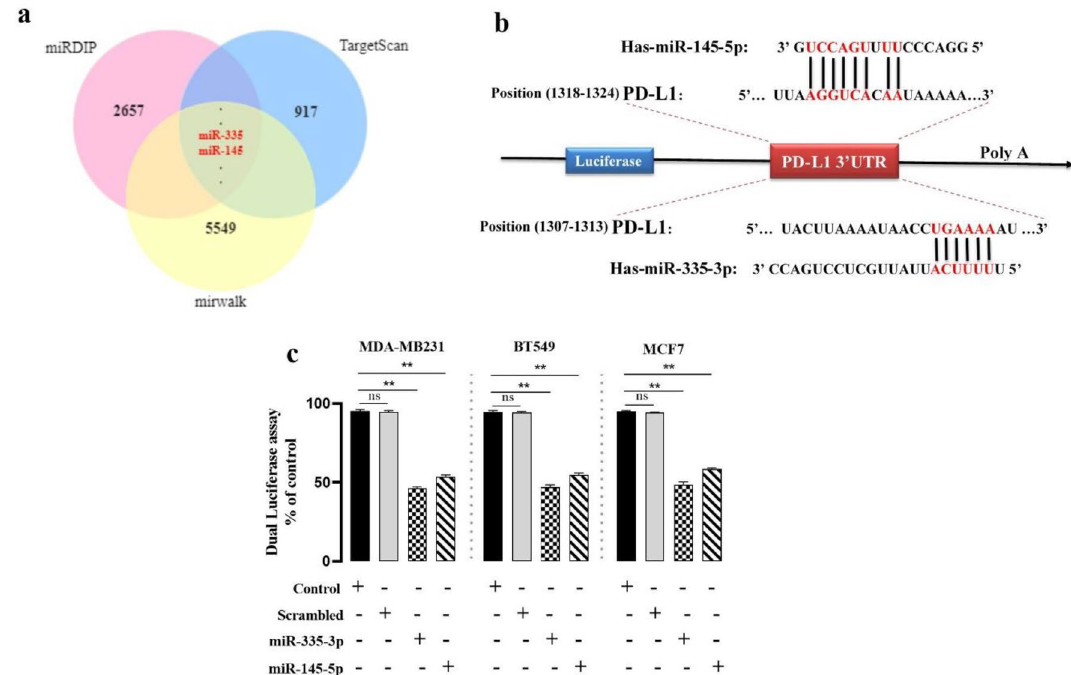
Figure 2. PD-L1 is a direct target of miR-335 and -145 in breast cancer cell lines. (a) MiR-335 and -145 downstream target genes predicted by miRDIP, target scan, and miRwalk ( b ) miR-335 and -145 are highly conserved across species and have binding sites within the 3 ′ -UTR of human PD-L1 ( c ) MDA-MB231; BT549; and MCF7 cells were transfected with renilla and firefly luciferase expression constructs from psiCHEC KTM-2 harboring PD-L1 3 ′ -UTR and miR-335 and -145, or scramble miR. Dual-Luciferase assays were done after 48 h. The relative Renilla luciferase activity went down, but the scramble miR had no effect. ns = non-significant, **P ≤ 0.01, ***P ≤